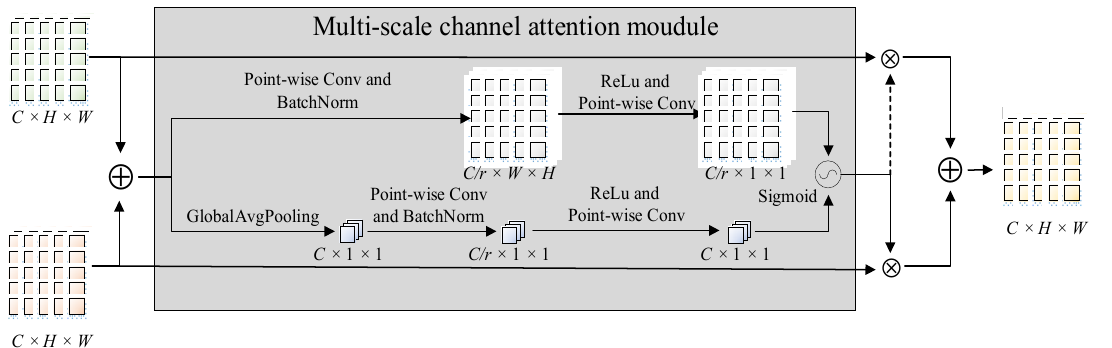
Figure 5. Structure of attentional feature fusion, where the dashed line denotes 1 − M ( X ⊕ Y ) .